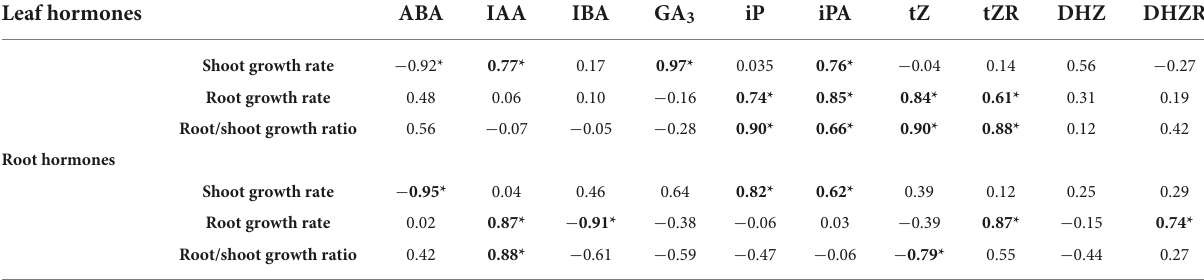
*Indicatesignificantcorrelationatthe0.05level.